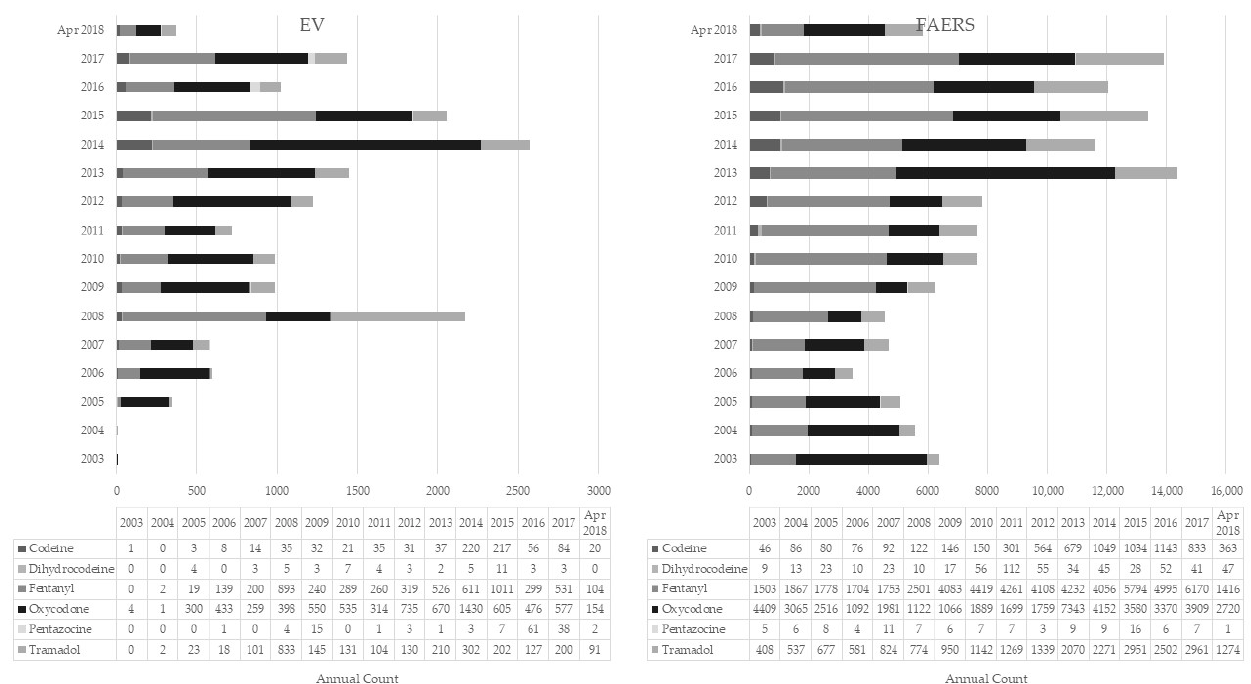
Figure 1. Number of cases involving opioids recorded in the European Medicines Agency (EMA) and Food and Drug Administration (FDA) Adverse Event Reporting System databases.